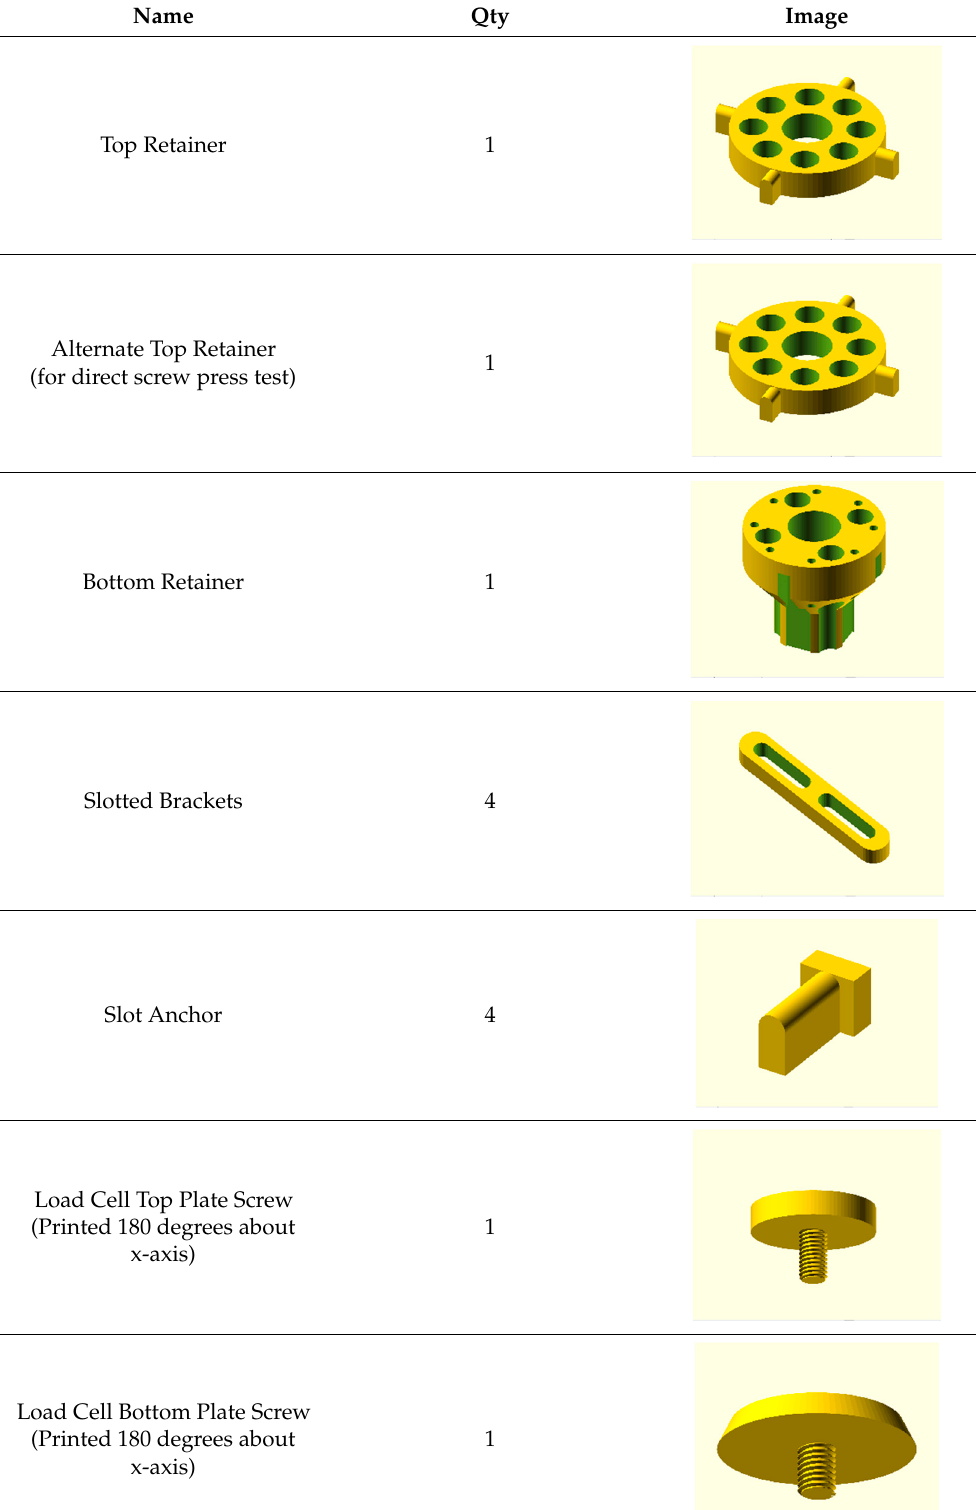
Table 5. BOM of test stand assembly.